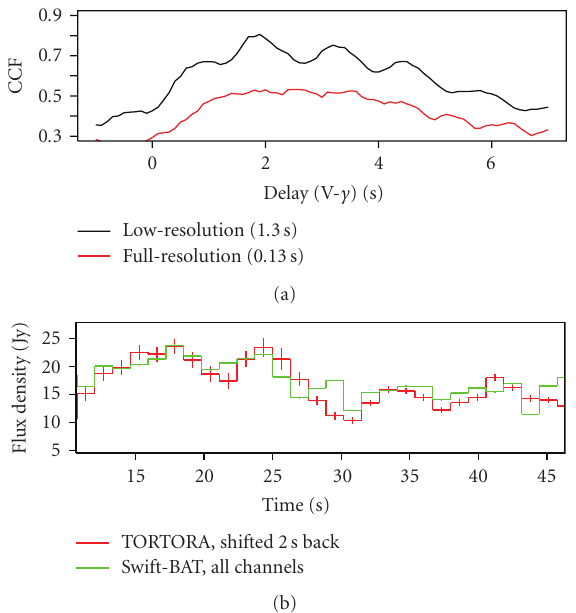
Figure 7: (a) Cross-correlation of the Swift-BAT gamma-ray (all energy channels) and TORTORA optical fluxes for the main (plateau) phase of the burst emission. (b) TORTORA optical flux shifted back 2 seconds along with correspondingly rebinned Swift- BAT gamma-ray flux. The correlation is r = 0 . 82 with significance level of 5 · 10 − 7 . Gamma-ray curve is arbitrarily scaled and shifted for illustrative